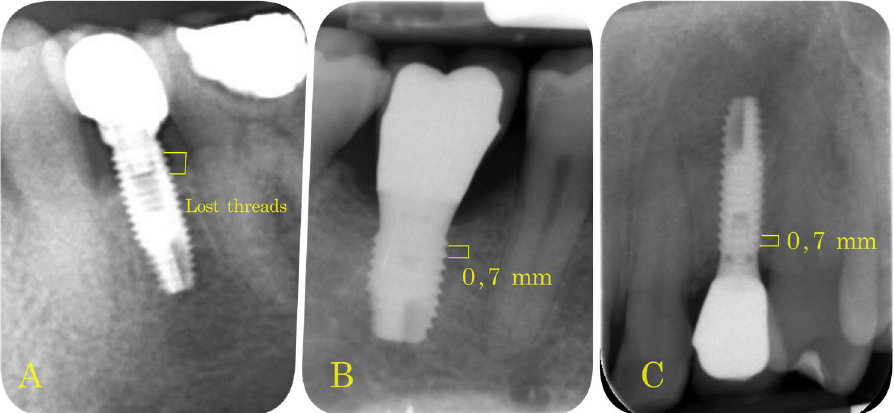
Figure 3. ( A ) Two lost threads in a mandible dental implant; ( B ) 0.7 mm represents the distance between threads (mandible dental implant); ( C ) 0.7 mm thread distance in a maxilla dental implant. Table 1. Distribution of the sample in relation to diameter, length, time of loading, and implant location. Implant